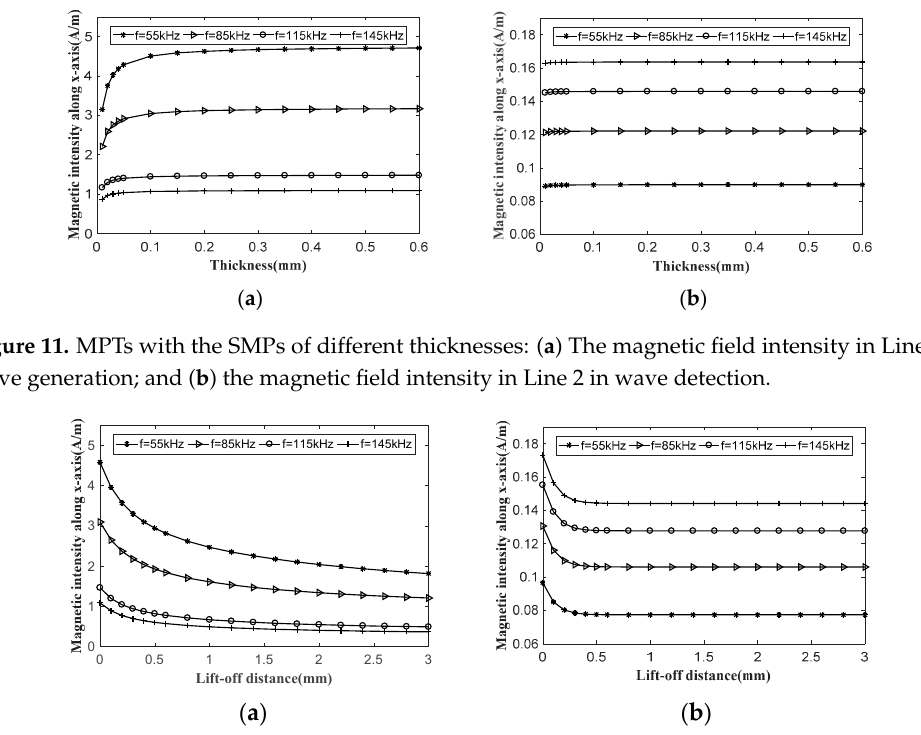
Figure 12. MPTs with the SMPs of different lift-off distances: ( a ) The magnetic field intensity in Line 1 in wave generation; and ( b ) the magnetic field intensity in Line 2 in wave detection.